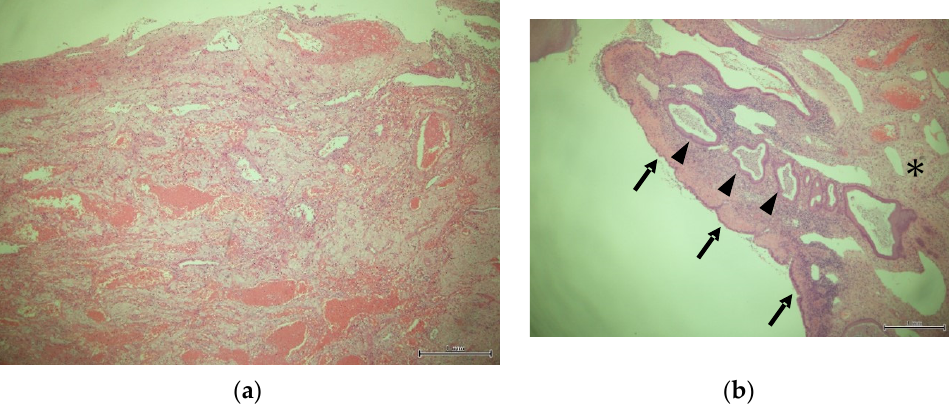
Figure 1. Decidual polyp showing abundant pink cytoplasm without epithelium and/or glandular structures ( a ) and endocervical polyp containing decidual change in stromal cells (* in ( b )). Arrows indicate endocervical epithelium covering a fibrovascular core and arrowheads indicate glandular structures within the endocervical